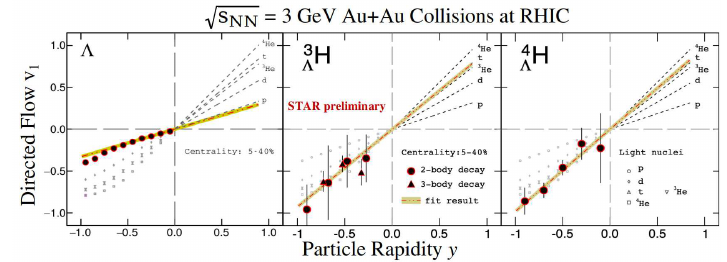
40% mid-central Au Figure 3. Hyper-nuclei v 1 as a function of rapidity from the √ s NN = 3 GeV 5 − + Au collisions at RHIC-STAR. In case of 3 H, both 2-body (dots) and 3-body (triangles) decays are Λ used. Results from fitting with a first-order polynomial function are shown as the yellow-red lines. The rapidity dependence of v 1 for p, d, t, 3 He and 4 He are also shown as open-circles, diamonds, up- triangles, down-triangles and squares, respectively. The corresponding results of the linear fits are shown as dashed lines in the positive rapidity